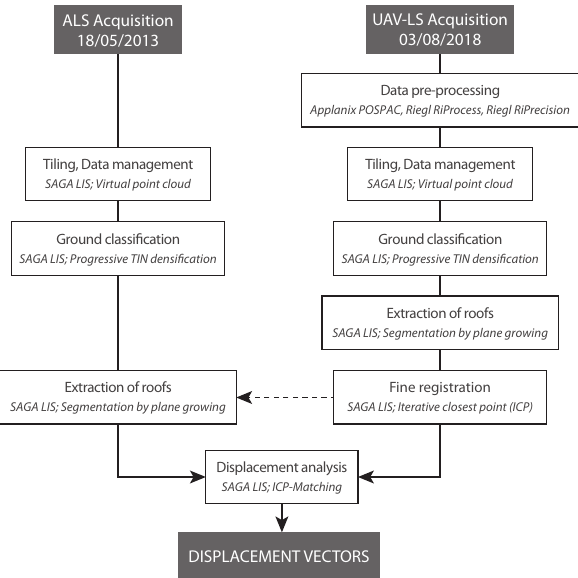
Figure 4. Workflow showing the main data processing